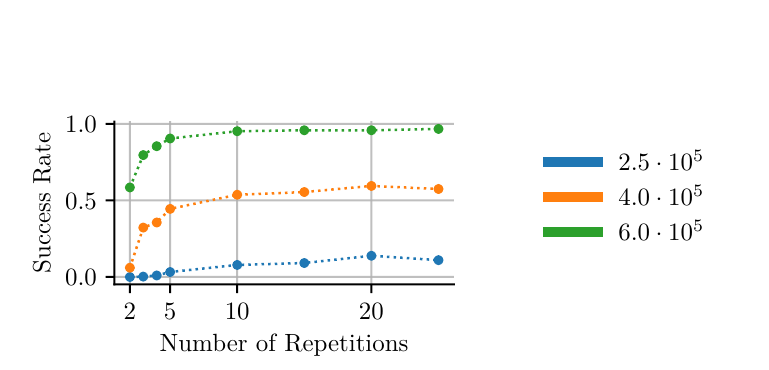
Figure 8: The impact of selecting different repetition numbers for the reliability compu- tation on the success rate is shown for an attack on the (1,8)-iPUF. Per point, 20 PUF instances with eight trials were attacked. Each curve depicts the success rate for a different training set size.